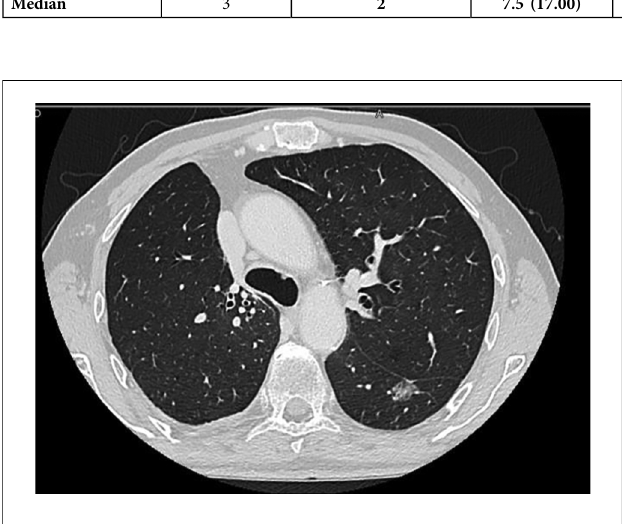
FIGURE 2 Intra-operative image showing the artery (A6) for the apical segment of the left lower lobe